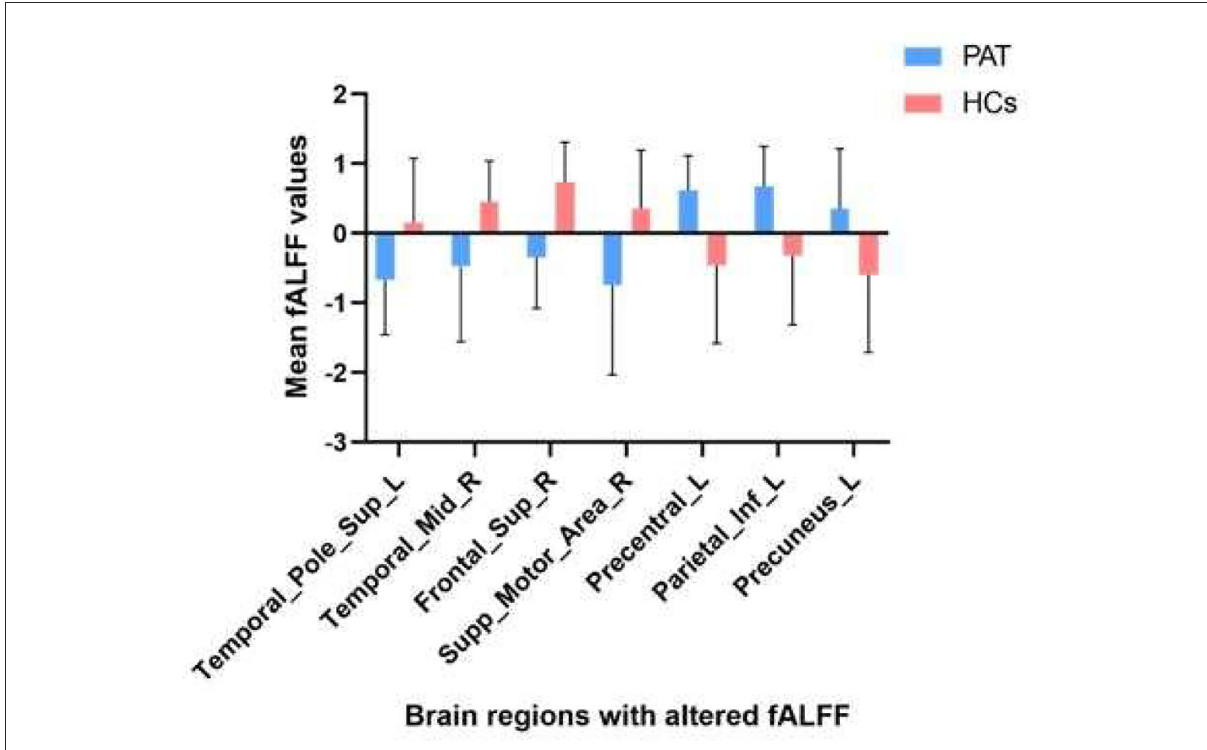
FIGURE2 The mean fALFF values between children with SA and